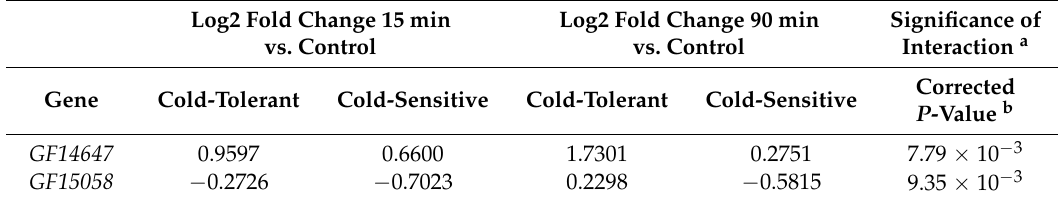
Table 3. Genes with significant phenotype x cold shock interaction in D. ananassae